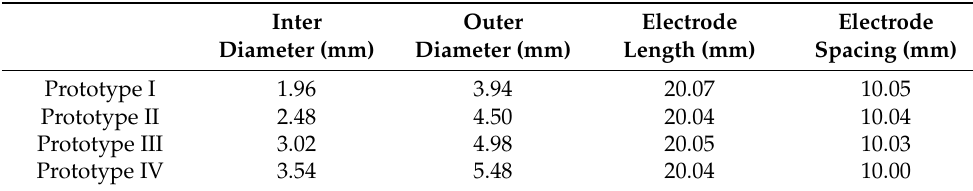
Table 1. The detailed information of the CID sensors.